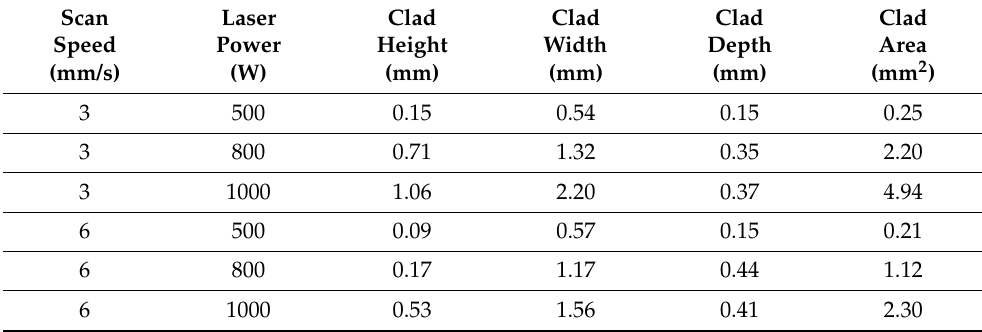
Figure 5. Parametric study of laser cladding on ( a , b ) U75V and ( c , d ) U20Mn rail steels. For all cases, the laser cladded four times (four layers) on the substrates. ( a , c ) Effect of scanning speed and ( b , d ) effect of laser power. Table 2. Geometry of cladded lines due to different laser powers and scanning